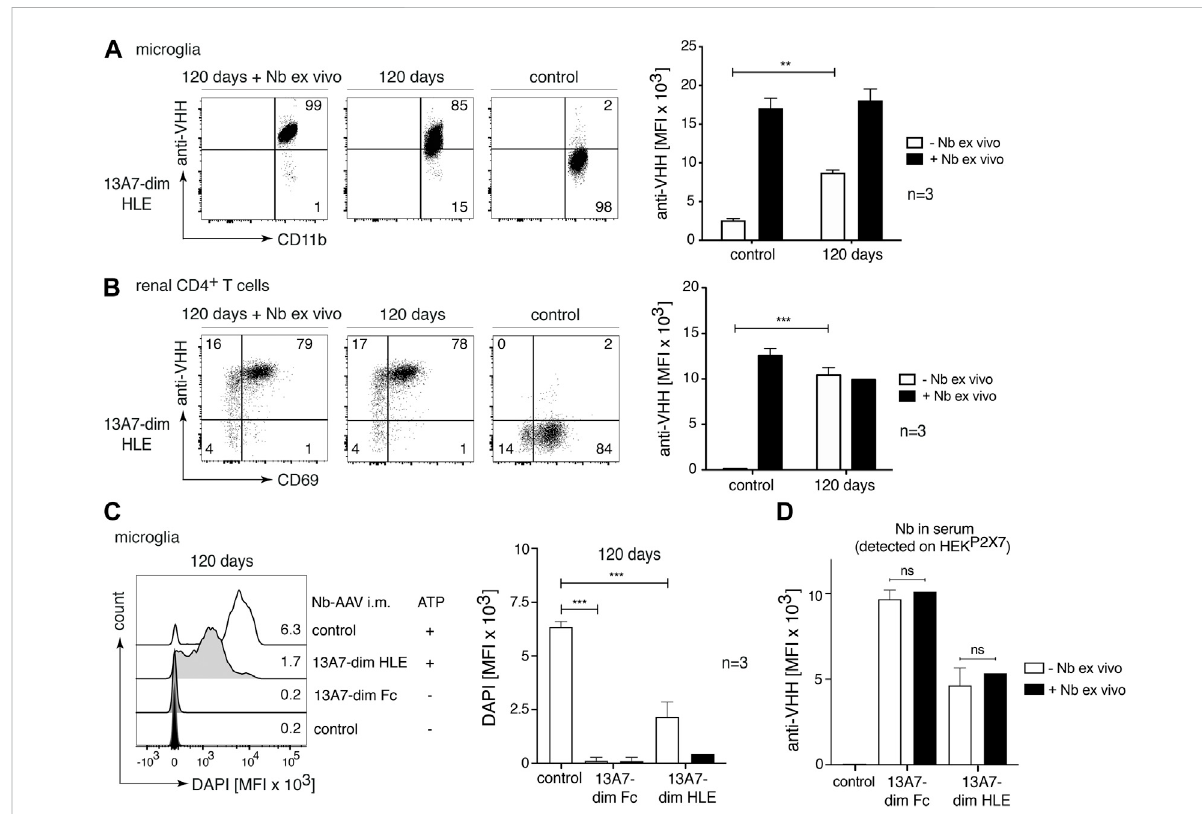
FIGURE 8 Near complete target occupancy and complete P2X7 inhibition on microglia 120 days after i.m. injection of AAV1 vectors coding for P2X7nanobodies.Micewereinjectedi.m.with10 11 viralgenomesofAAV1codingfor13A7-dimHLEand13A7-dimFc.After120 days,theoccupancy of P2X7 by the nanobodies was analysed on microglia and kidney-resident helper T cells (T RMs ), as described in Figure 2. Flow cytometry dot plots of microglia (A) or renal CD4 + T cells (B) illustrate the relative occupancy of P2X7 at 120 days after i.m. injection of AAV1-Nb versus the maximal occupancyachievedafter exvivo additionofsaturatingnanobodies(+Nb exvivo ).BardiagramsillustratetheoccupancyofP2X7onmicroglia (A) and renal CD4 + Tcells (B) obtained from AAV1-Nb injected andcontrol mice (n= 3/group). (C) P2X7function, as determined bytheATP-induced uptake of DAPI by microglia, was assessed by fl ow cytometry. Bar diagrams illustrate DAPI uptake by microglia from three AAV1-Nb injected and three control mice in the absence (- Nb ex vivo ) or presence (+ Nb ex vivo ) of saturating nanobodies added ex vivo . (D) Circulating nanobodies were measured in the serum of transduced mice. Serum (1:100) was incubated with HEK P2X7 cells. Bound 13A7-dim HLE nanobodies were detected by anti-VHH mAb and BV421-conjugated IgG1-speci fi c mAb, and bound 13A7-dim Fc nanobodies by BV421-conjugated IgG1-speci fi c mAb. Bar diagrams illustrate the MFI of HEK P2X7 cells from AAV1-Nb injected and control mice (n = 3/group). Dot plots shown are from a single mouse. An independent experiment refers to an experiment with a single mouse per condition, in which all mice were analyzed on the same